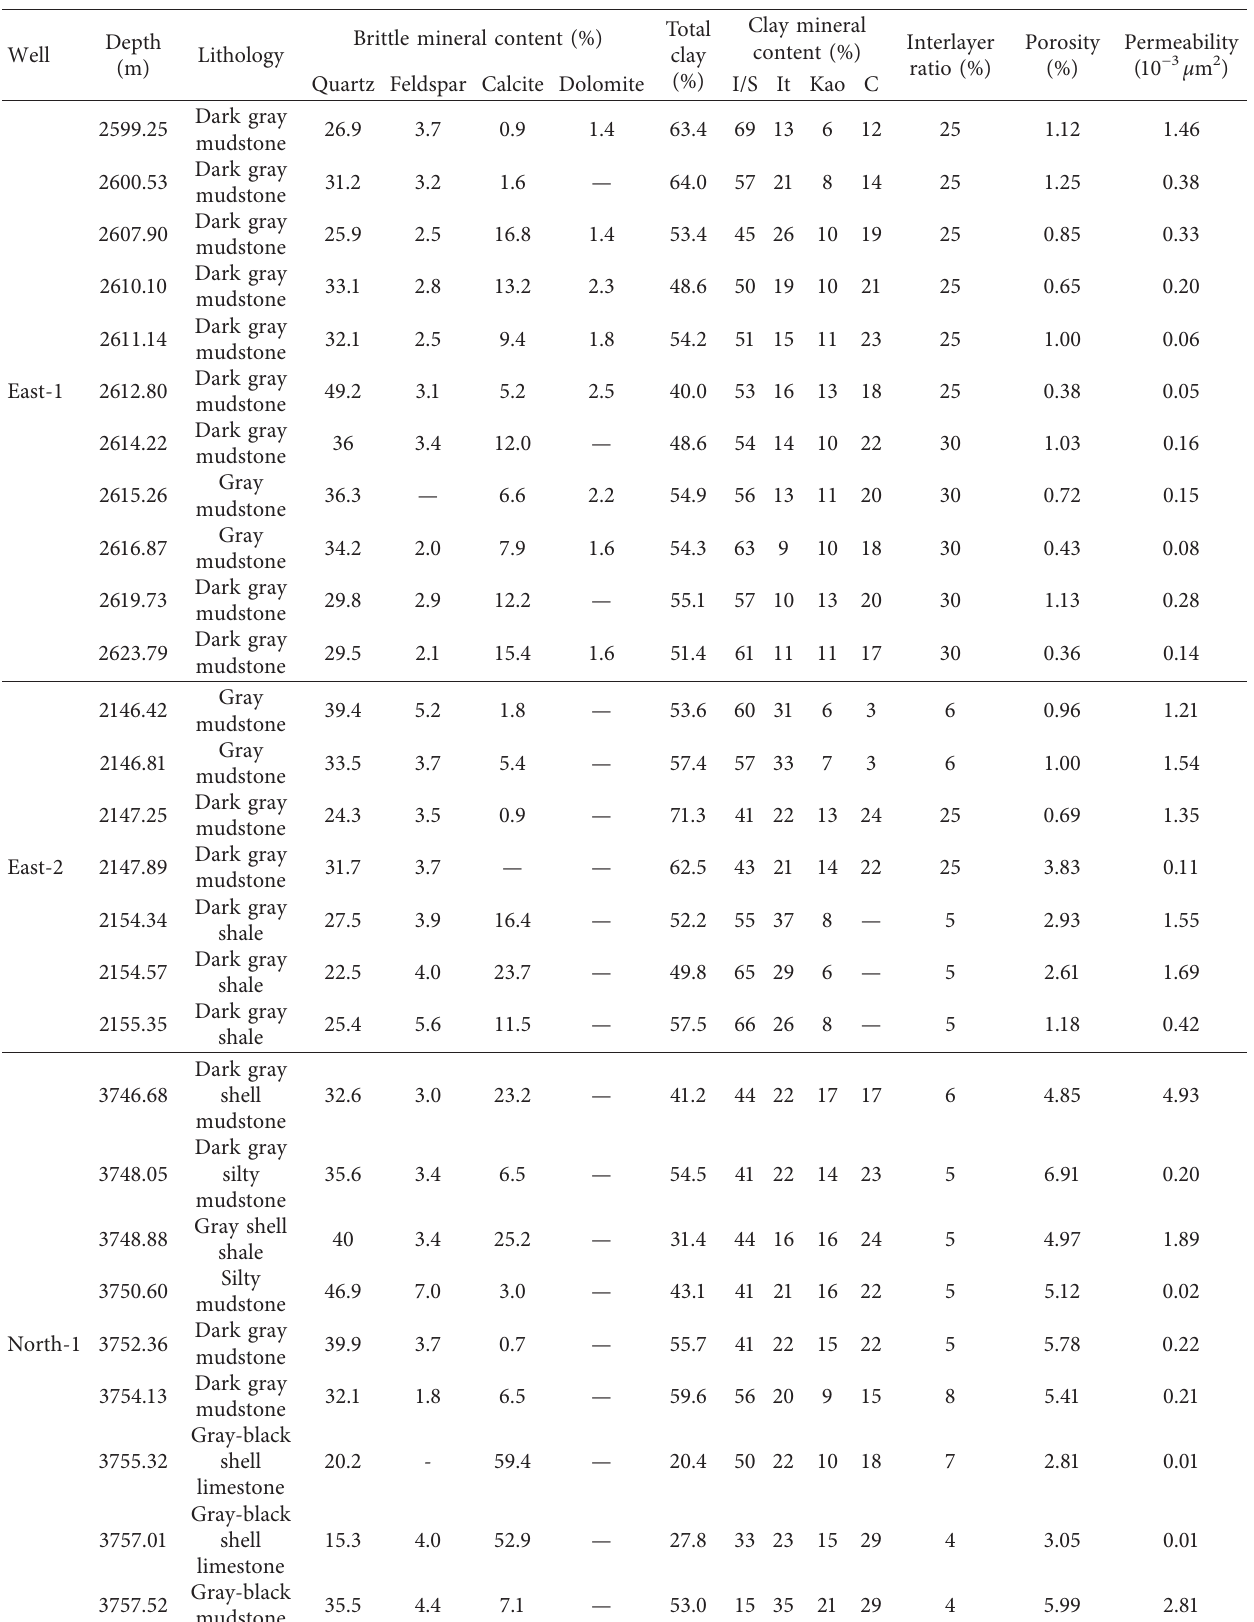
Table 1: The XRD analysis of mineral components and corresponding porosity-permeability data tables of fine-grained rocks in the Da’anzhai Member in different areas of the Sichuan Basin.